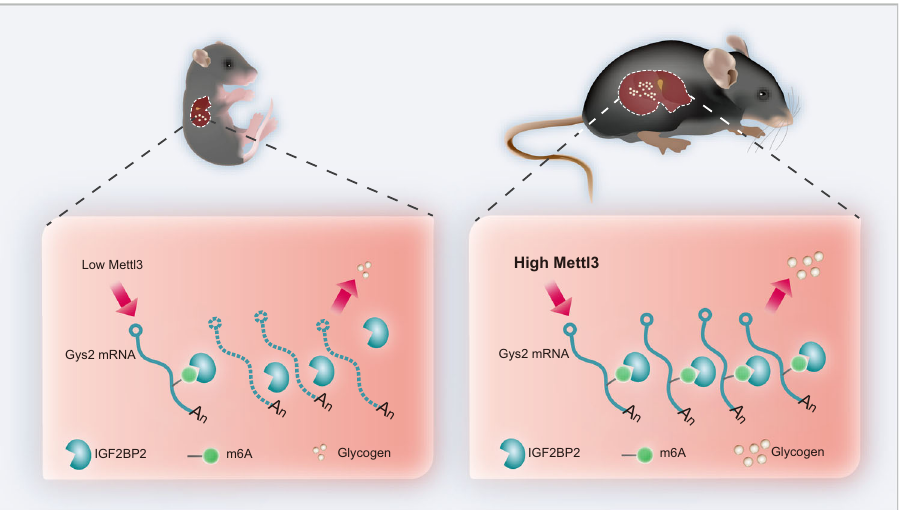
Fig. 7 | Model for m6A regulation of Gys2 mRNA in the liver. METTL3-IGF2BP2- GYS2 axis controls glycogenesis in mammalian liver. On the one hand, this axis